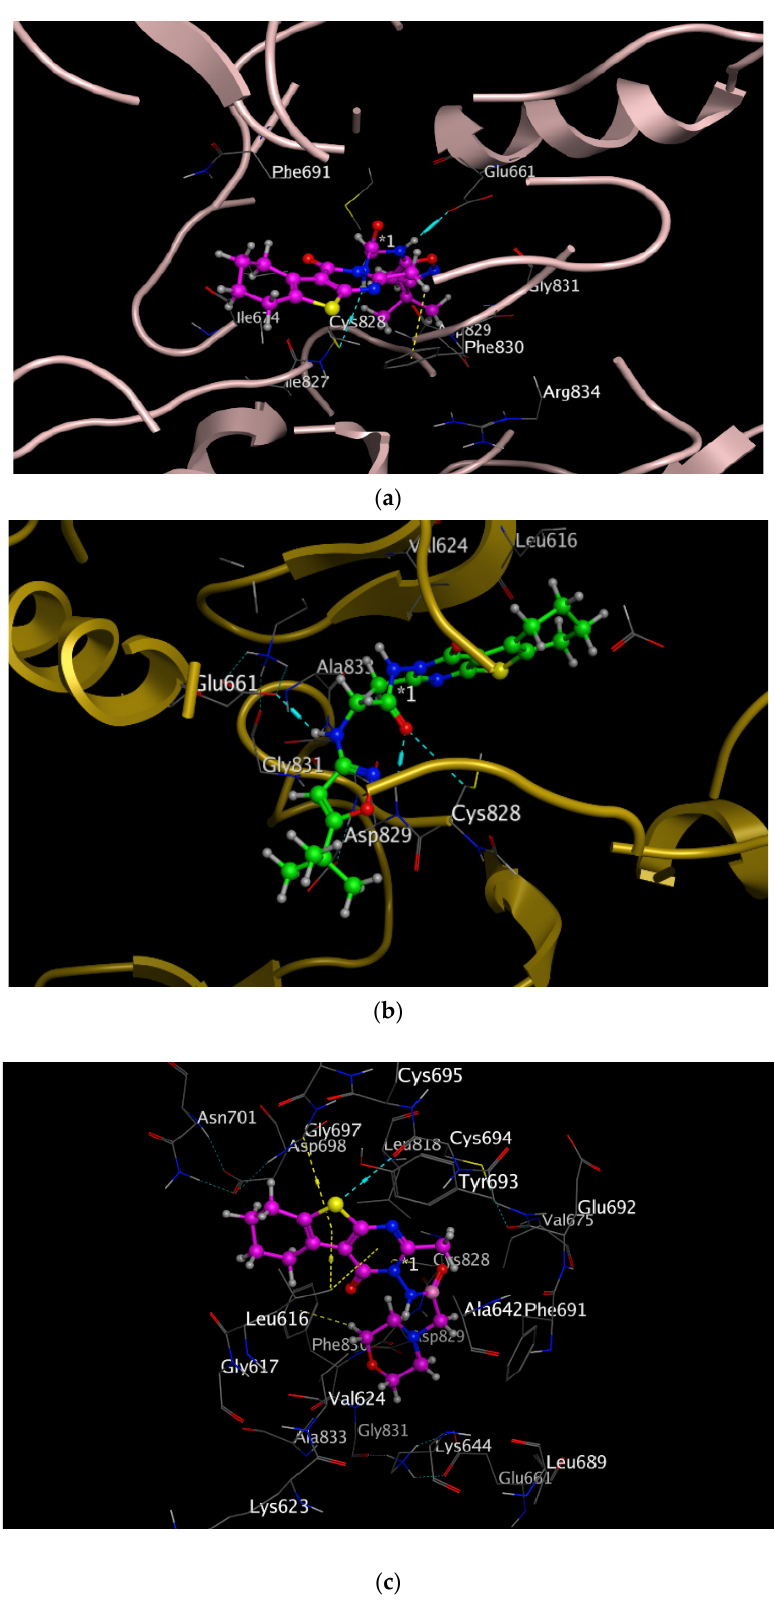
Figure 7. Compounds 9a , 9b and 10a interactions inside the active site of FLT3 with H-bonds in cyan and H- Pi interaction in yellow. ( a ) 9a (in magenta ball and stick) ( b ) 9b (in green ball and stick). ( c ) 10a (in magenta ball and